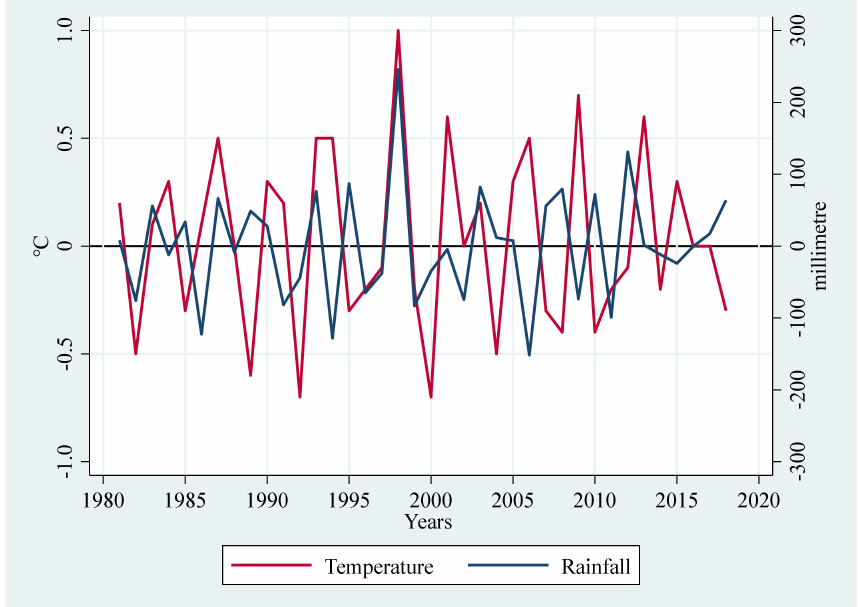
Figure 2. Temperature change and rainfall change in Sichuan province (Source: Weather Bureau of Sichuan Province